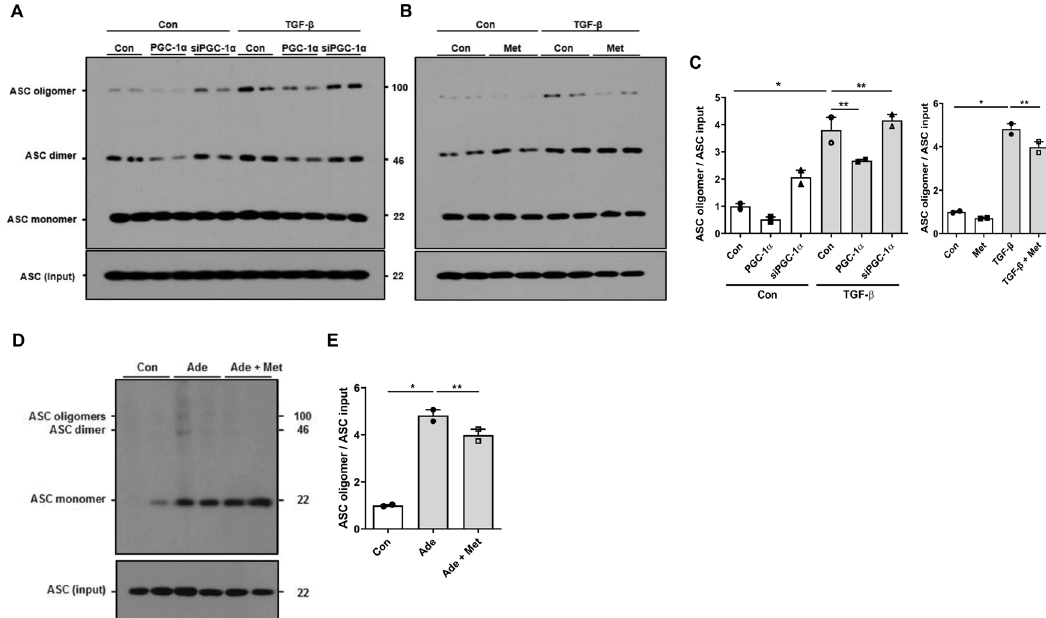
Fig. 6 PGC-1 α modulates oligomerization of NLRP3 in fl ammasome during kidney injury. A – C ASC oligomeric structures assayed by DSS- mediated cross-linking were observed in TGF- β 1-treated RTECs, which were attenuated by overexpression of Ppargc1a and metformin, whereas aggravated by siPGC-1 α . D , E ASC oligomeric structures were observed in adenine-fed mice, which were attenuated by metformin. Note: * P < 0.05 vs. control; ** P < 0.05 vs. TGF- β 1-treated RTECs or adenine-fed mice. PGC-1 α peroxisomal proliferator- γ coactivator-1 α ; NLRP3 NOD-like receptor family, pyrin domain-containing 3; ASC apoptosis-associated speck-like protein containing a caspase recruitment domain; DSS disuccinimidyl suberate; RTEC renal tubular epithelial cell; Ade adenine; Met